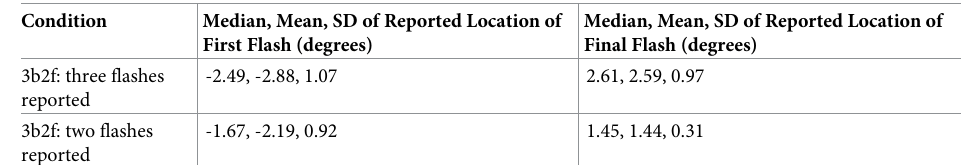
Table 1. Experiment 1.2 illusory rabbit